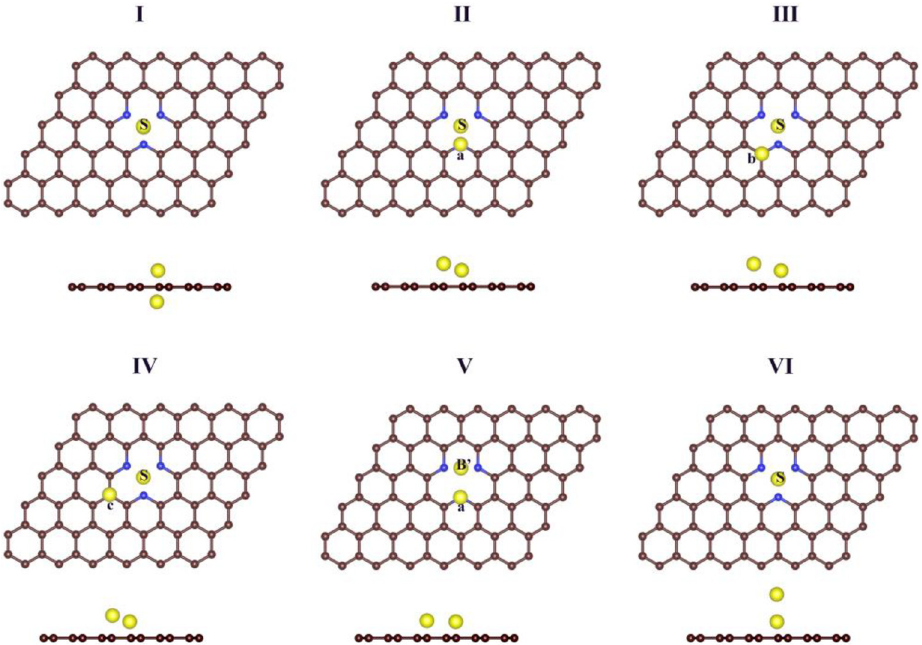
Figure 3. Color code: C, black; N, blue; TM, yellow. The six initial configurations are marked as ( I – VI ).